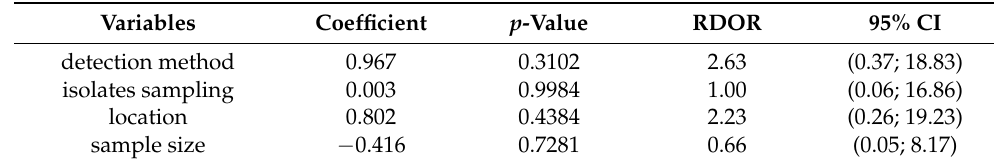
Table 4. Meta-regression analysis of the detection method, isolates sampling, location, and sample size of the group 2–128 mg/L. RDOR, relative diagnostic odds ratio.